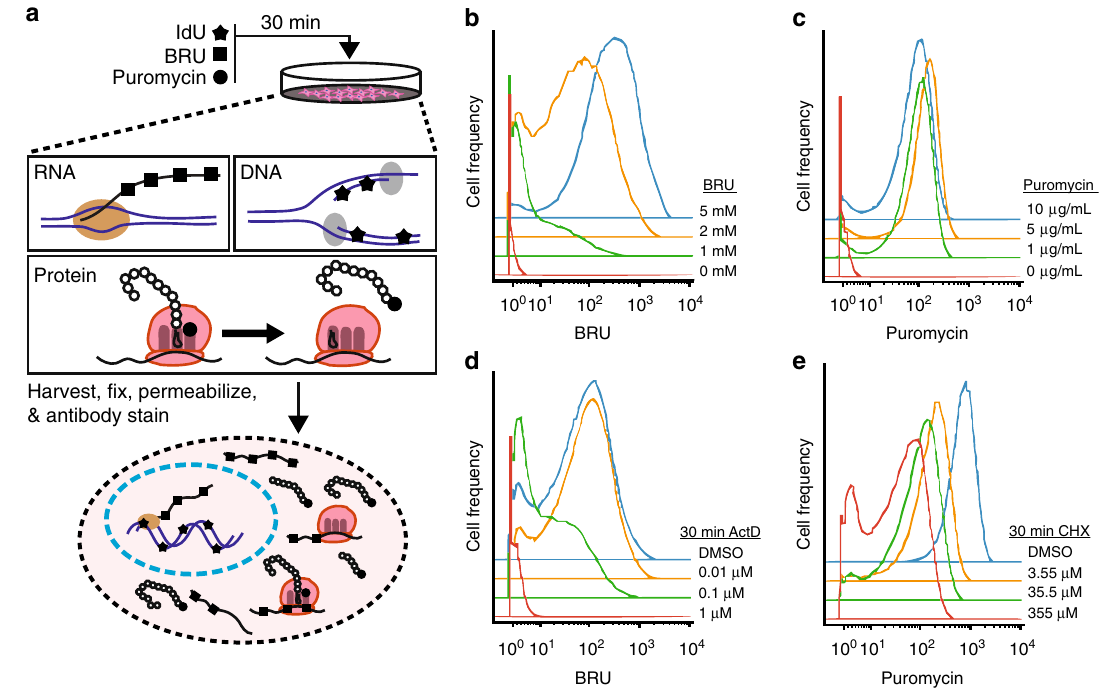
Fig. 1 SOM 3 B, simultaneously captures de novo DNA, RNA, and protein synthesis in transient, asynchronous cell systems. a Overview of biomolecule labeling with 5-Iodo-2-deoxyuridine (IdU), 5-Bromourdine (BRU), and puromycin incorporation into each biomolecule based on their active synthesis. b , c Mass-cytometry quanti fi cation of incorporated BRU ( b ) and puromycin ( c ) in HeLa cells pulsed with increasing concentration of each label molecule, detected with isotope labeled antibodies. d , e Histogram of BRU and puromycin incorporation in HeLa cells pre-treated with increasing concentration of Actinomycin D (ActD) ( d ) or Cycloheximide (CHX) ( e ), respectively. Experiments were performed multiple times, and representative plots